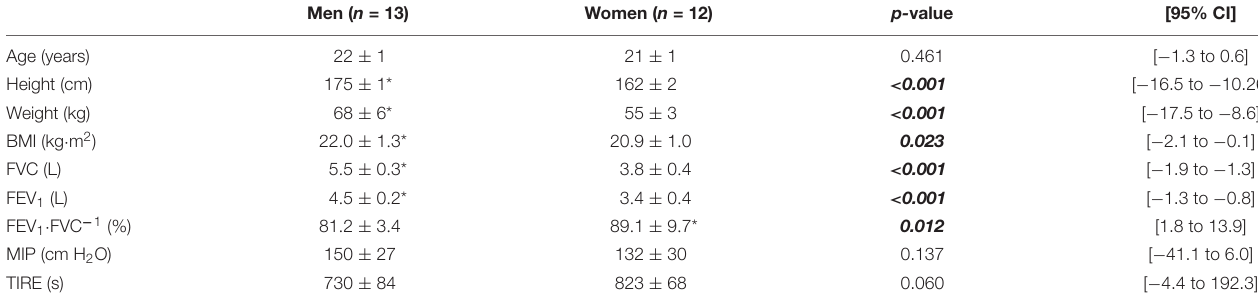
TABLE 1 | Participants’